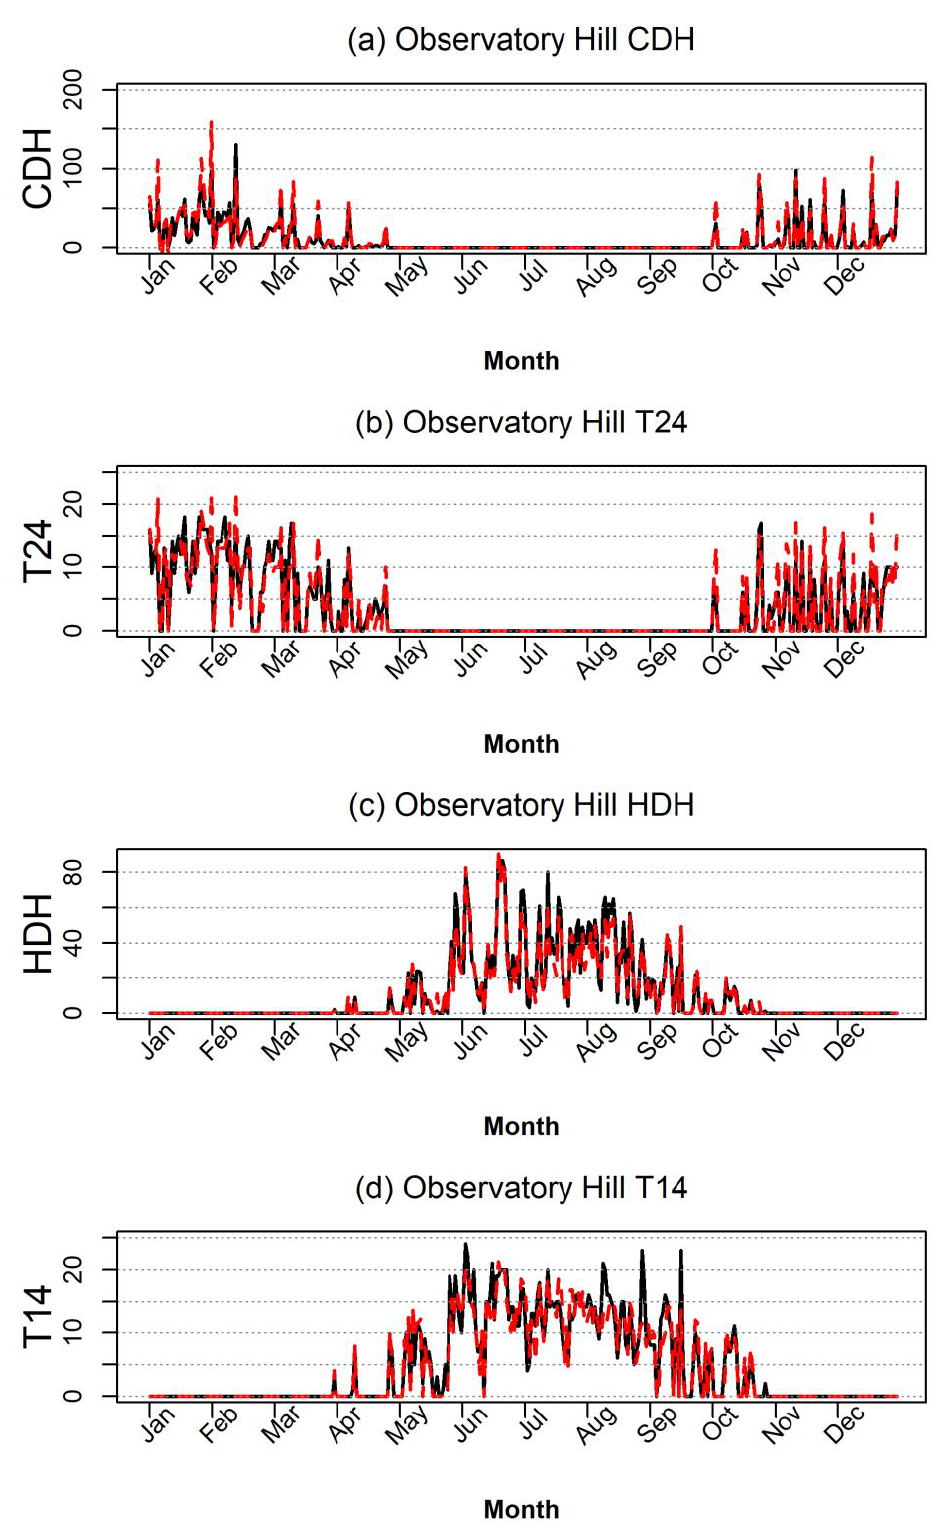
Figure 8. Observed (black solid) and estimated (red dotted) values from the empirical models for T24 and T14 values for the year 2019 at the Observatory Hill station.